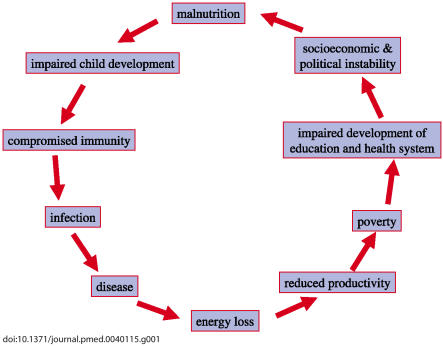
Protein Energy Malnutrition Increases Prevalence of Infection, Leading to Energy Loss for the IndividualOn the community level, this burden reduces productivity, including food production, and perpetuates the relentless spiral of further malnutrition, infection, disease, poverty, and socioeconomic and political instability.